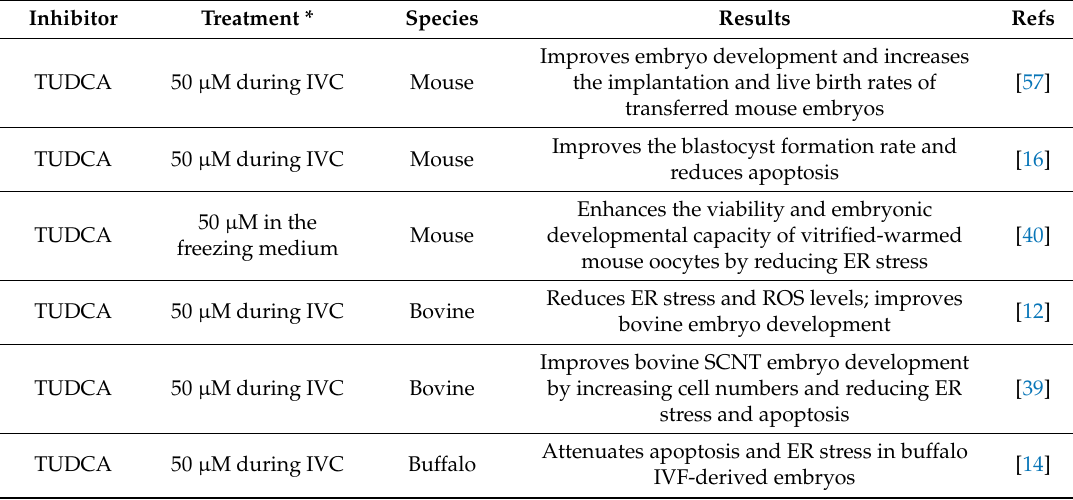
Table 3. The positive influence of Endoplasmic Reticulum stress inhibitor supplementation during IVM/IVC on mammalian oocyte maturation and/or embryo